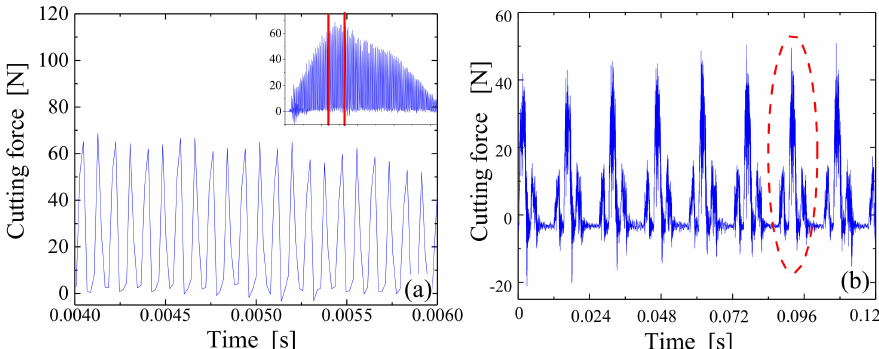
Figure 9. Predicted and experimental results of cutting force (cutting speed is 25 m / min, feed per tooth is 0.008 mm / z, width of cut is 0.15 mm, rake angle is 5 ◦ , relief angle is 12 ◦ , helix angle is 30 ◦ , cutting edge radius is 0.01 mm, longitudinal amplitude is 5 µ m, torsional amplitude is 4 µ m, and frequency is